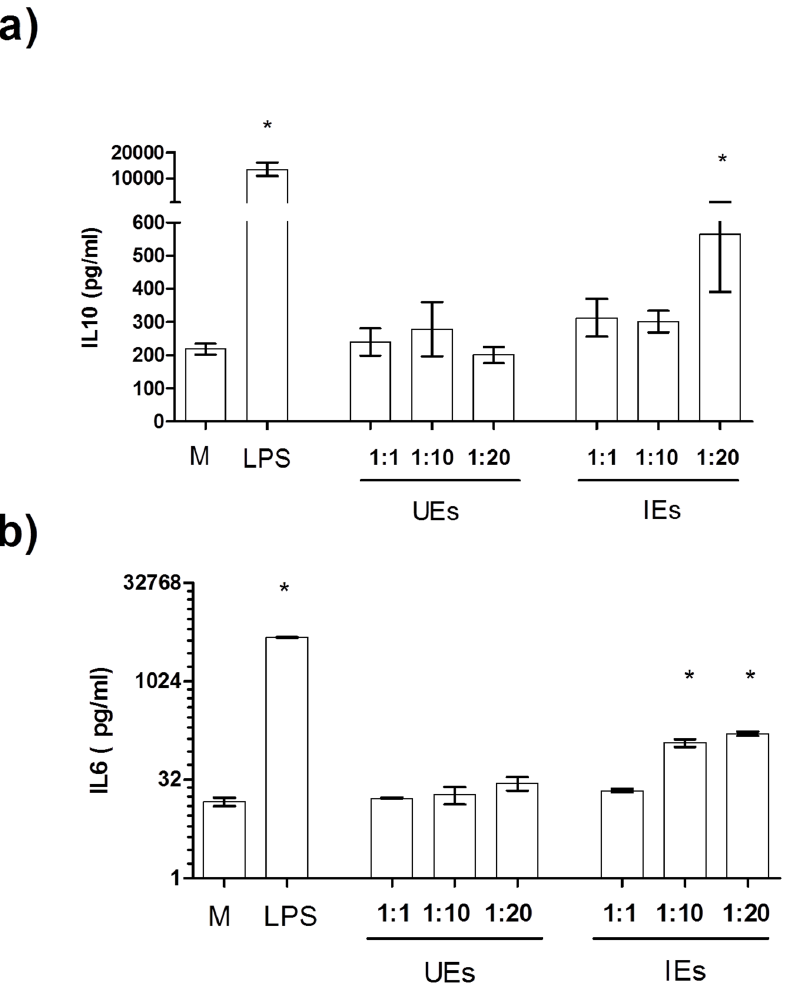
Figure 1. Concentration of IL-10 and IL-6 in supernatants of primary macrophages cultured with erythrocytes infected with Plasmodiumfalciparum (IEs) or uninfected erythrocytes (UEs) for 12 hours at increasing macrophage to parasite ratios. Data show mean concentration of (a) IL-10 and (b) IL-6 from 3 independent experiments. Error bars indicate standard error of the mean. M=media, LPS=lipopolysaccharide. * P , 0.05 (Mann-Whitney test, compared with Media control).